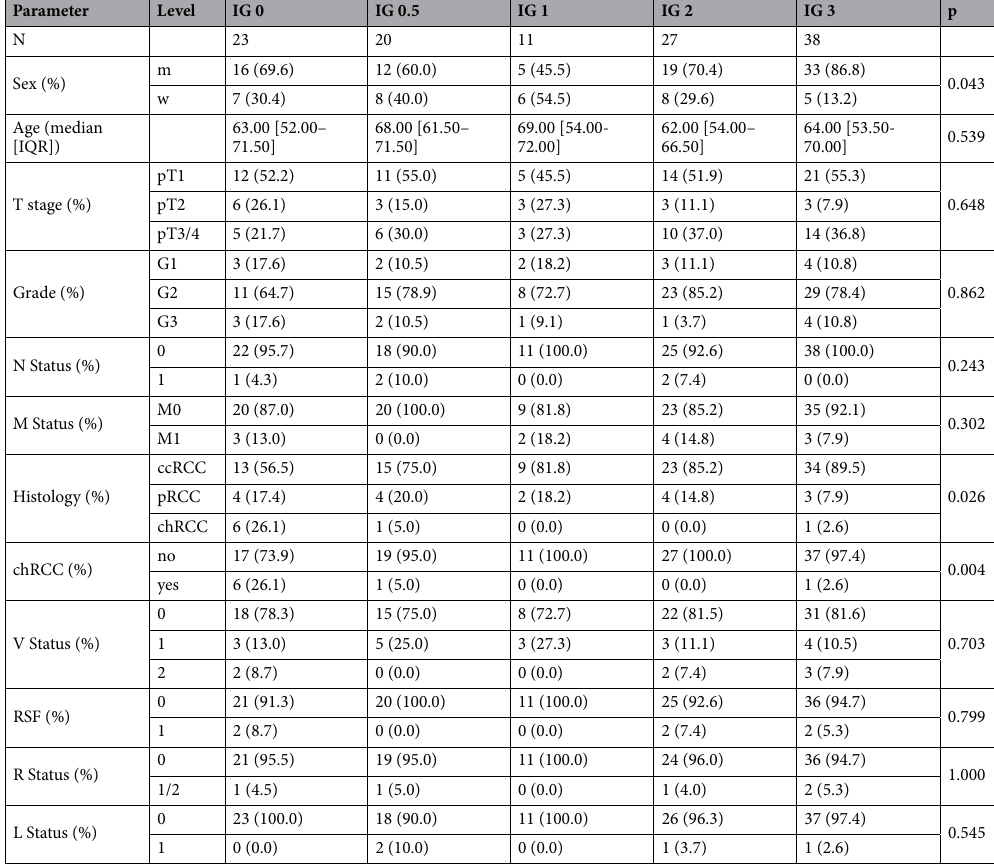
Table 2. Association of intensity of Gal3ST1 expression with risk factors (Fisher’s exact test). IG intensity grade, RSF renal sinus fat